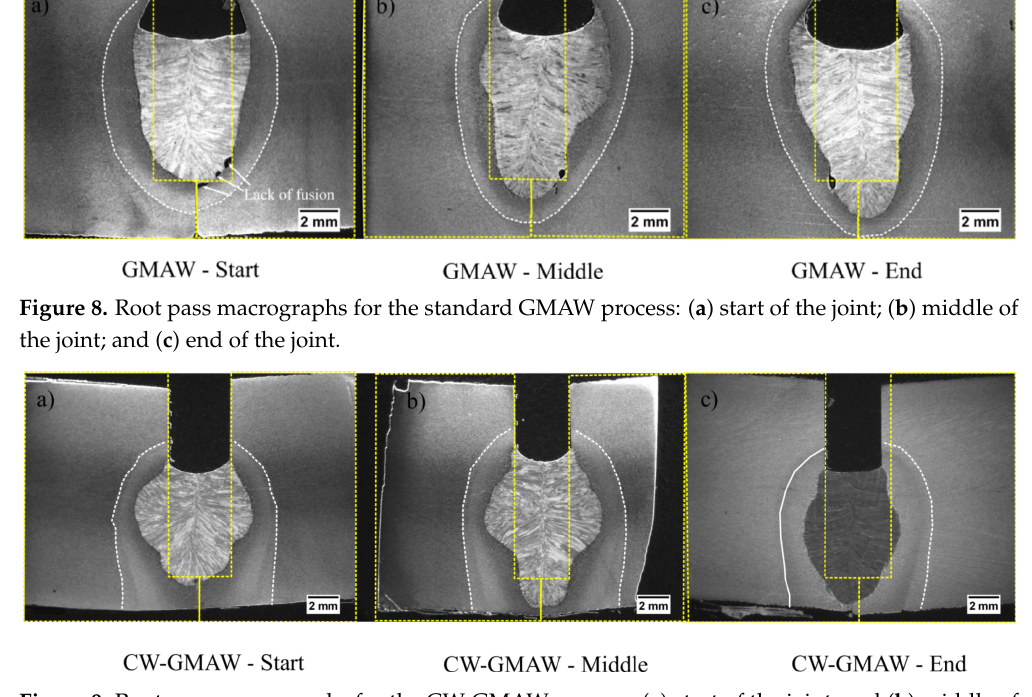
Figure 9. Root pass macrographs for the CW-GMAW process: ( a ) start of the joint; and ( b ) middle of the joint; and ( c ) end of the joint.